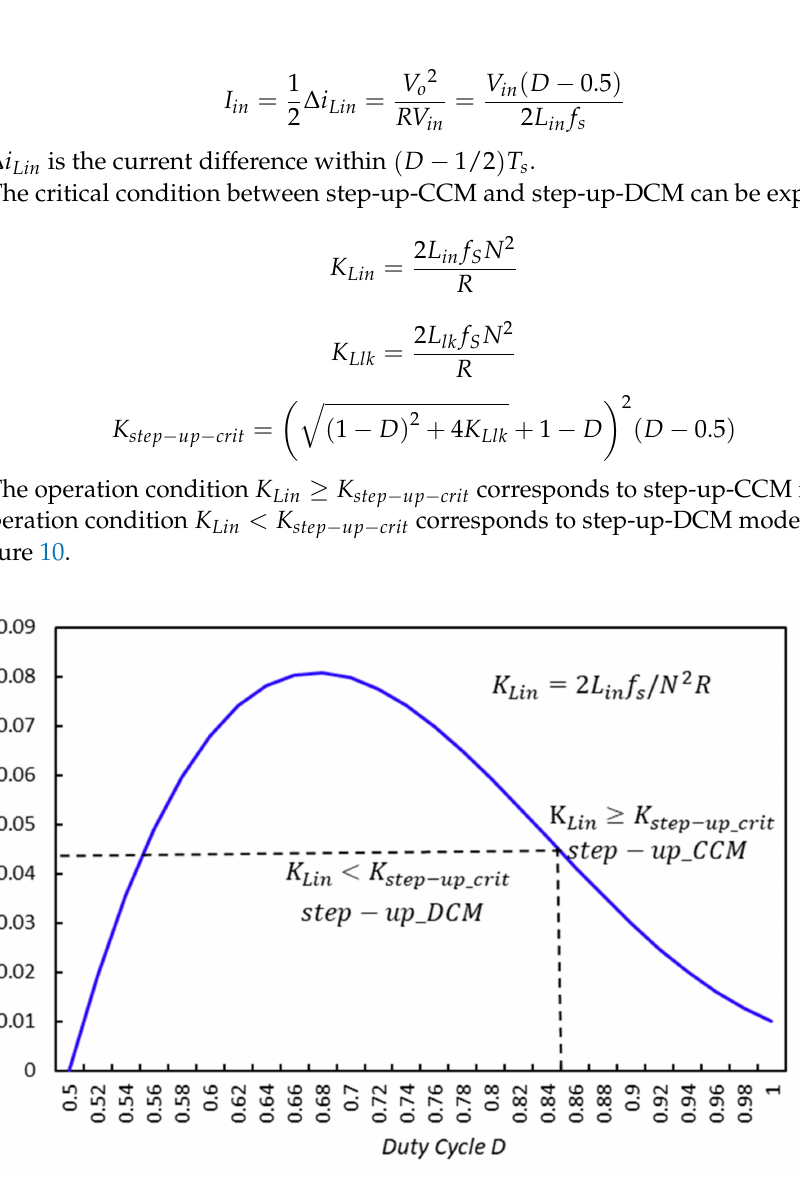
Figure 10. Boundary between step-up-CCM mode and step-up-DCM